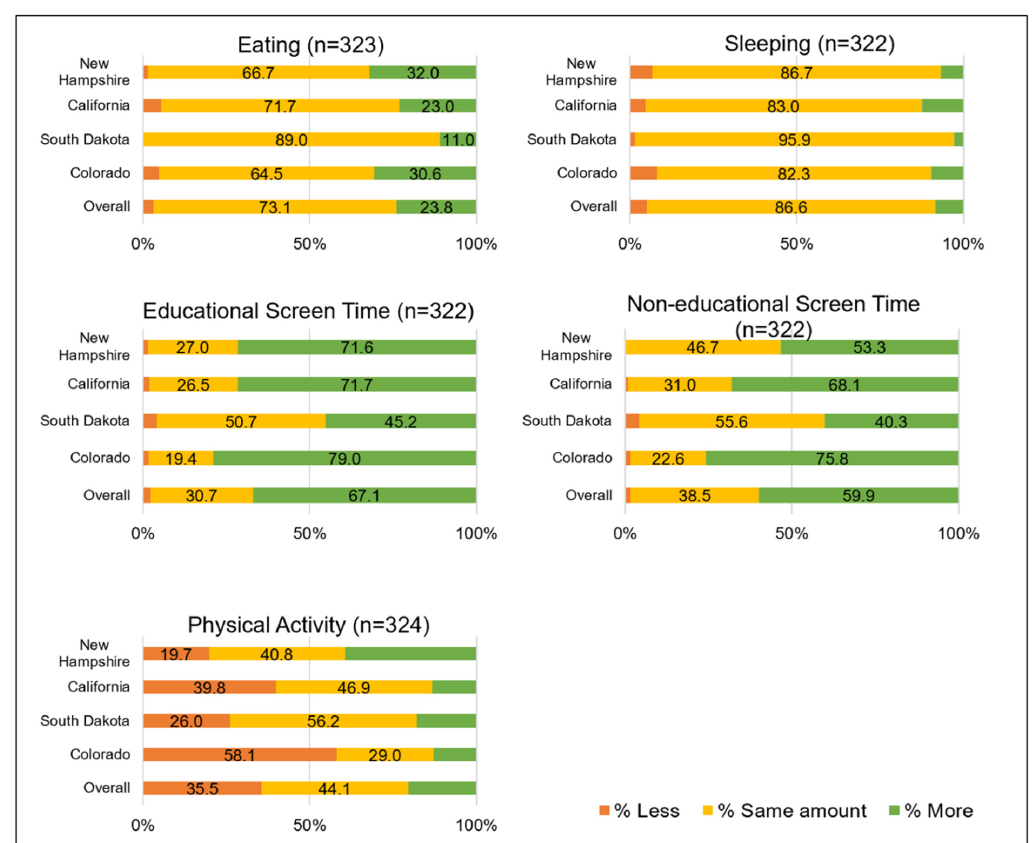
Figure 1. Perceived changes in children’s health behaviors during the COVID-19 pandemic among parents of children ages 4–12 years in 4 cohorts participating in the Environmental influences on Child Health Outcomes Program. Results are presented for the full sample and by recruitment site. Table 2 shows the unadjusted changes in reported health behaviors between the pre- pandemic and pandemic time periods. Total screen time increased on weekdays (3.0 vs.